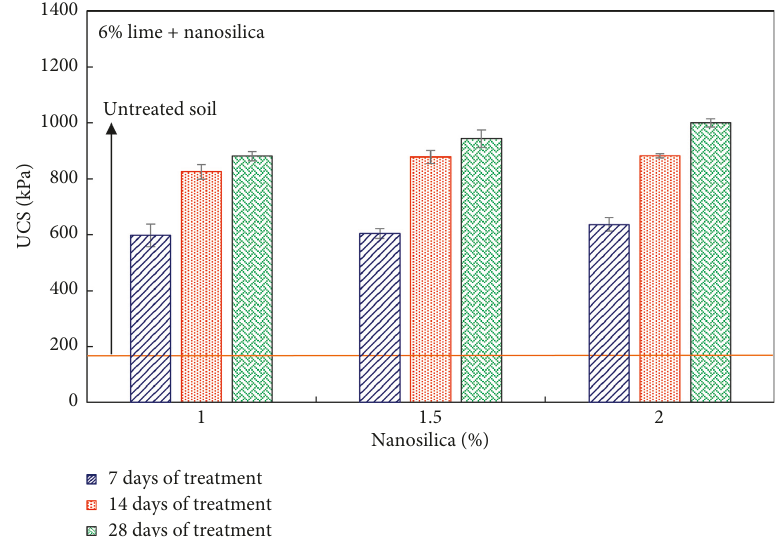
Figure 7: Effect of nano-SiO 2 on the UCS of lime-stabilized soil after a curing time of up to